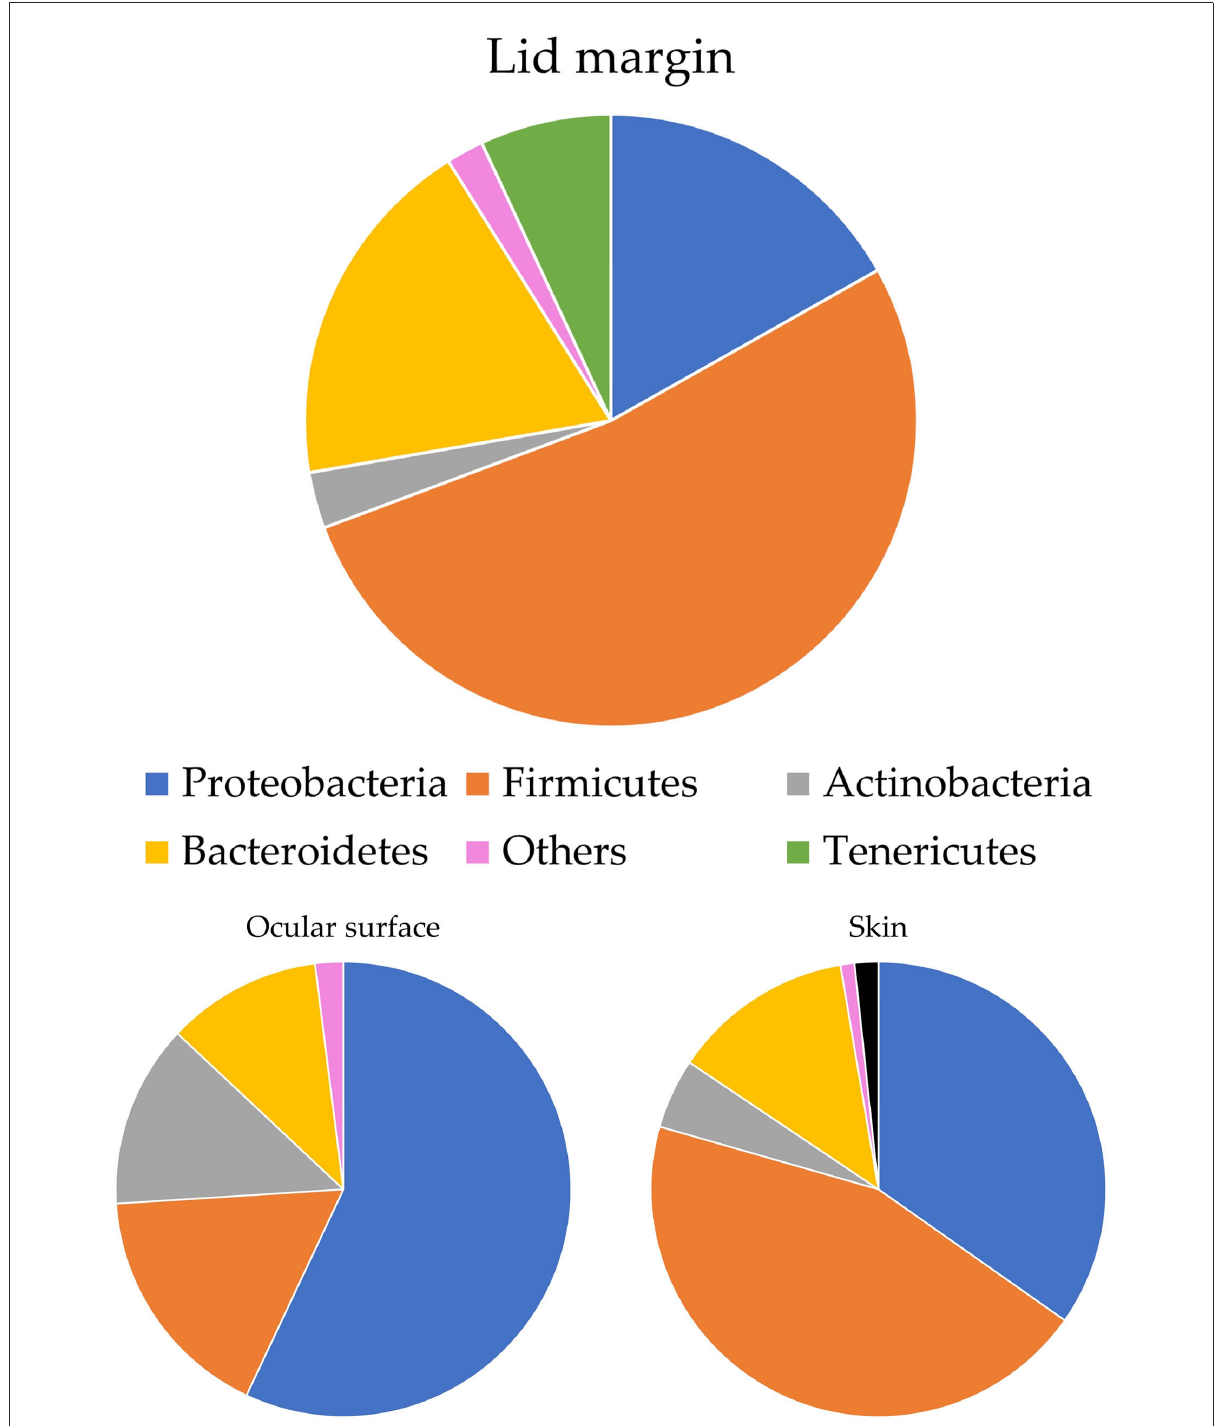
FIGURE2 OSM distribution on ocular surface by Cavuoto et al. (2019). Firmicutes are the most abundant flora of the lid margin, while Ozkan et al. (2019) have reported that Proteobacteria is the most prevalent here. The two studies agree that Proteobacteria is the most common phyla of the ocular surface and that periocular skin is dominated by